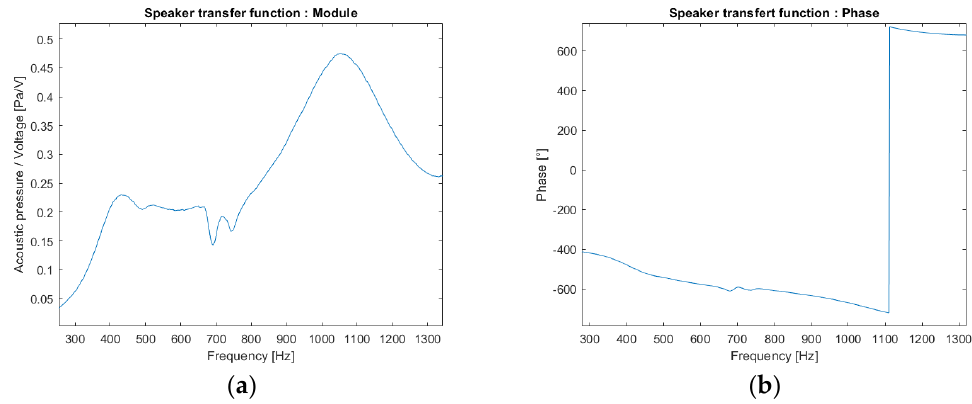
Figure 6. Transfer function of the loudspeaker estimated by emitting a white noise: ( a ) modulus; ( b ) phase.